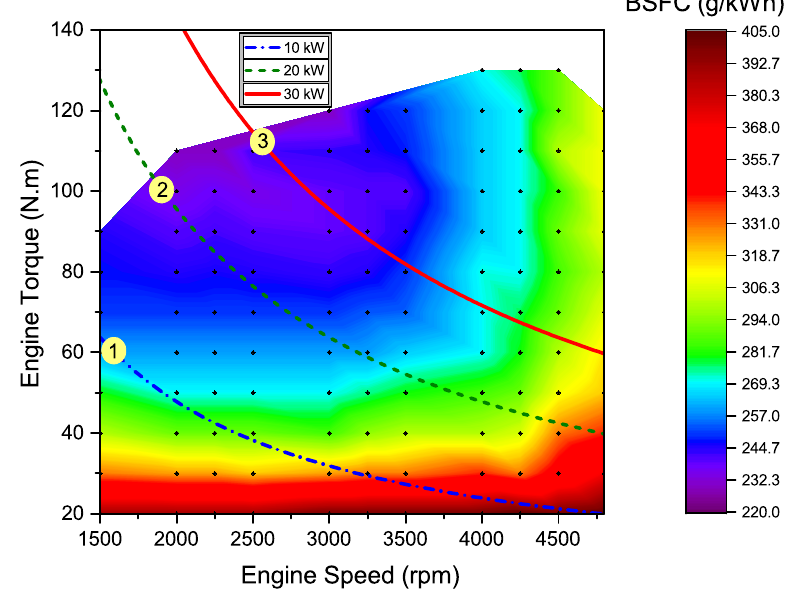
Figure 5. BSFC map (g/kWh) of GM A14XFL SI (gasoline) engine. The data from [41] was used to generate this